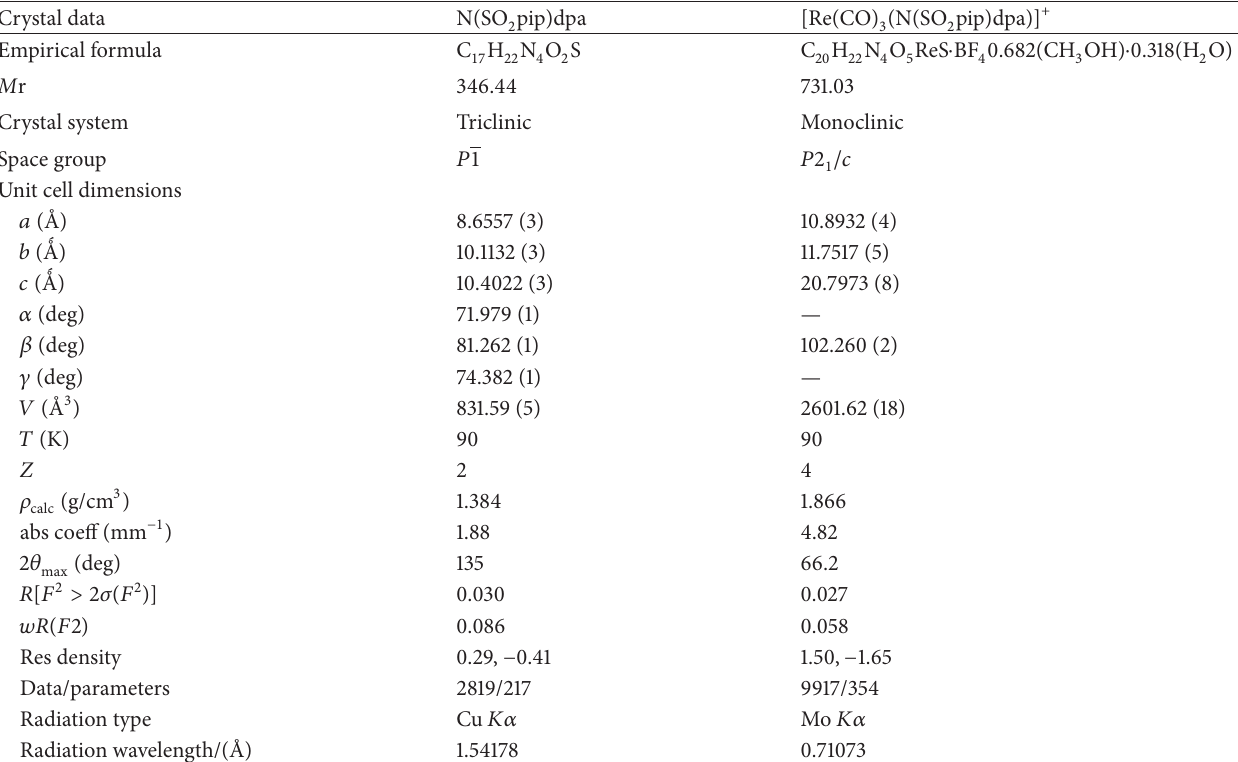
Table 1: Crystal data and structure refinement for N(SO 2 pip)dpa and [Re(CO) 3 (N(SO 2 pip)dpa)] + .